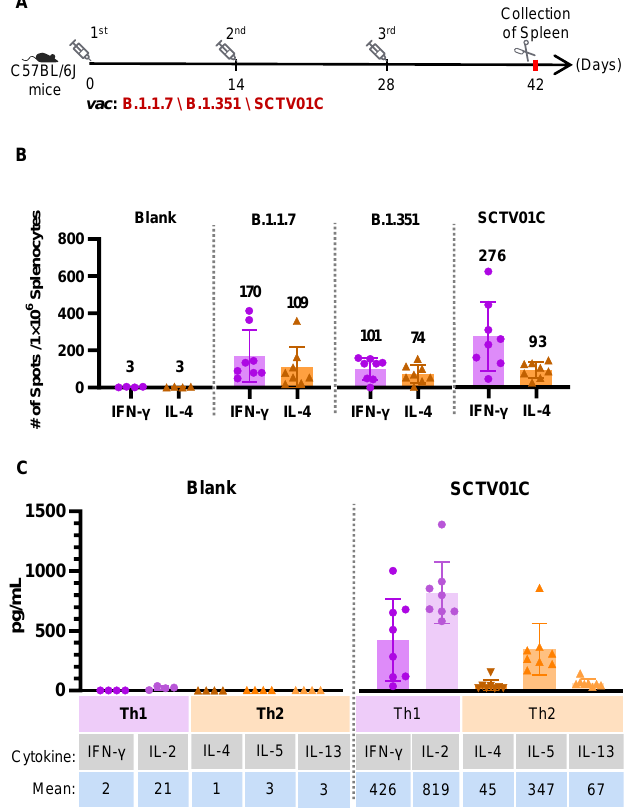
Figure 4. Th1 responses induced by the B.1.1.7 monovalent, B.1.351 monovalent and SCTV01C biva- lent vaccines. ( A ) Scheme of immunization and tissue processing. C57BL/6J mice (n = 8/group) were immunized with B.1.1.7 monovalent vaccine (1 µ g/dose), B.1.351 monovalent vaccine (1 µ g/dose), or SCTV01C (1 µ g/dose for each antigen) on days 0, 14 and 28. Splenocytes from immunized mice were stimulated with SARS-CoV-2 spike protein S polypeptides on day 42. ( B ) Number of IFN- γ (Th1 cytokine) and IL-4 (Th2 cytokine) positive Spot-forming cells (SFC) was evaluated. ( C ) Th1 (IFN- γ , IL-2) and Th1 (IL-4, IL-5 and IL-13) cytokines in culture supernatants from S peptides-stimulated mouse splenocytes were measured by flow cytometry. The results are representative of 3 independent experiments. Vac is an abbreviation for Vaccine. Bars show mean ±